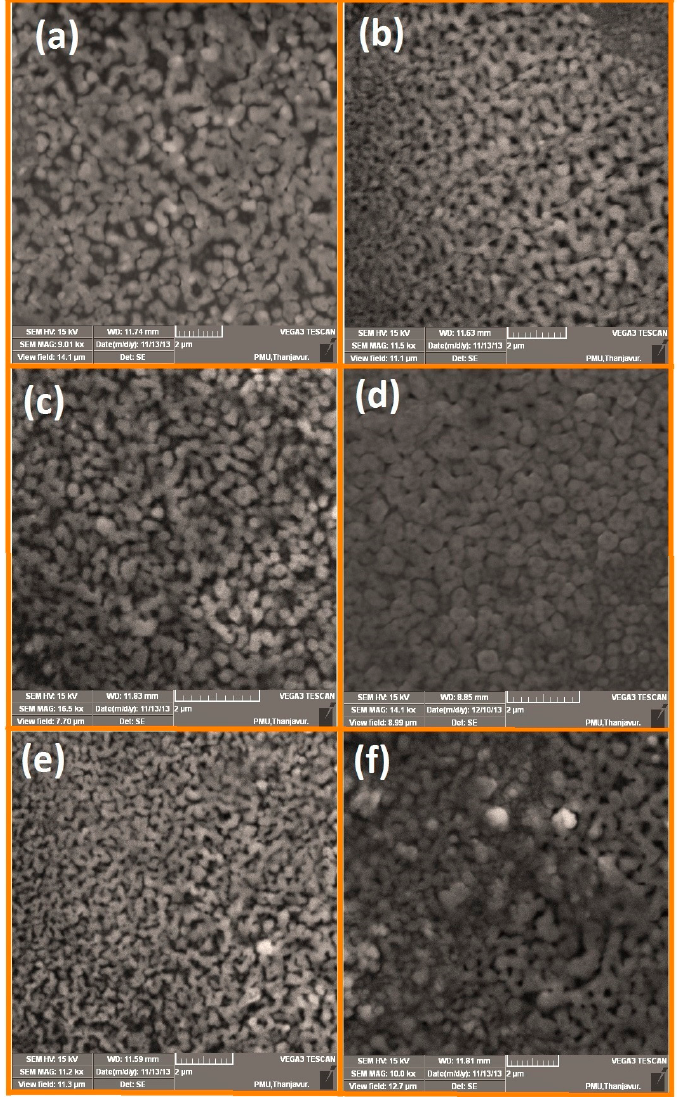
Figure 4. SEM images of Sn:CdO thin films deposited with different precursor volumes and Sn concentrations: ( a ) 0.1 mM in 10 mL; ( b ) 0.1 mM in 50 mL; ( c ) 0.2 mM in 10 mL; ( d ) 0.2 mM in 50 mL; ( e ) 0.3 mM in 10 mL; and ( f ) 0.3 mM in 50 mL. The topographical image of un-doped CdO and Sn:CdO (10 mL of 0.3 mM Sn) taken by atomic